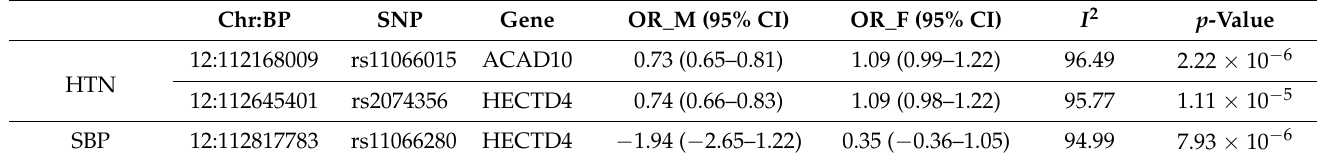
Table 5. Significant results in the heterogeneity test of hypertension and systolic blood